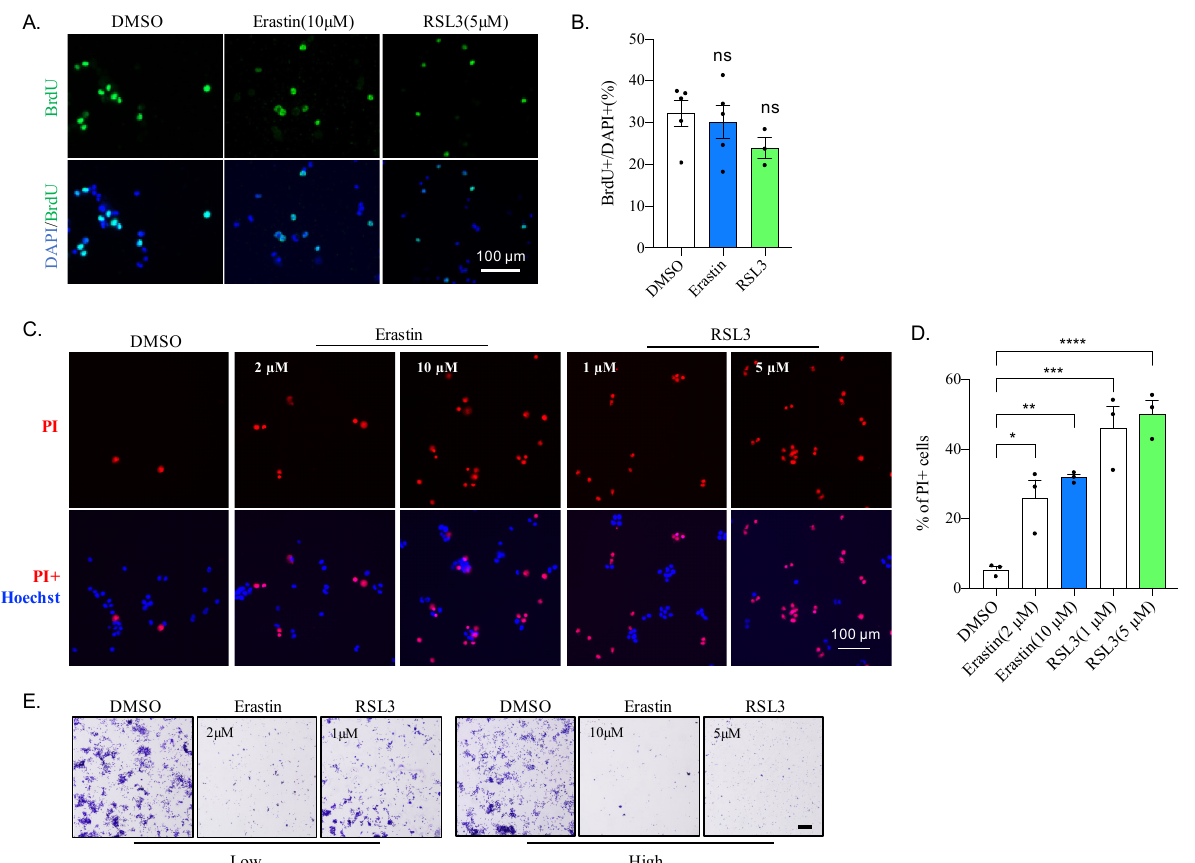
Figure 2. Erastin and RLS3 on proliferation and cell death in N2A cells ( A ) Representative images of BrdU staining. N2A cells were plus labeled for 1 h after treating for 23 h with DMSO, 10 µ M of Erastin or 5 µ M of RSL3. Cells were then fixed for BrdU antibody staining. Scale bar = 100 µ m. ( B ) Quantification of ( A ), data were obtained from triplicated experiments. ns: not significant. ( C ) Fluorescent images of N2A cells with PI staining. N2A cells were treated for 12 h with Erastin or RSL3. Scale bar = 100 μ m. ( D ) The quantification of ( B ) *: p < 0.05; **: p < 0.01; ***: p < 0.001; ****: p < 0.0001. ( E ). Bright-field images of N2A cells with Crystal violet staining. N2A cells were treated for 24 h with Erastin or RSL3. Scale bar = 500 μ m.